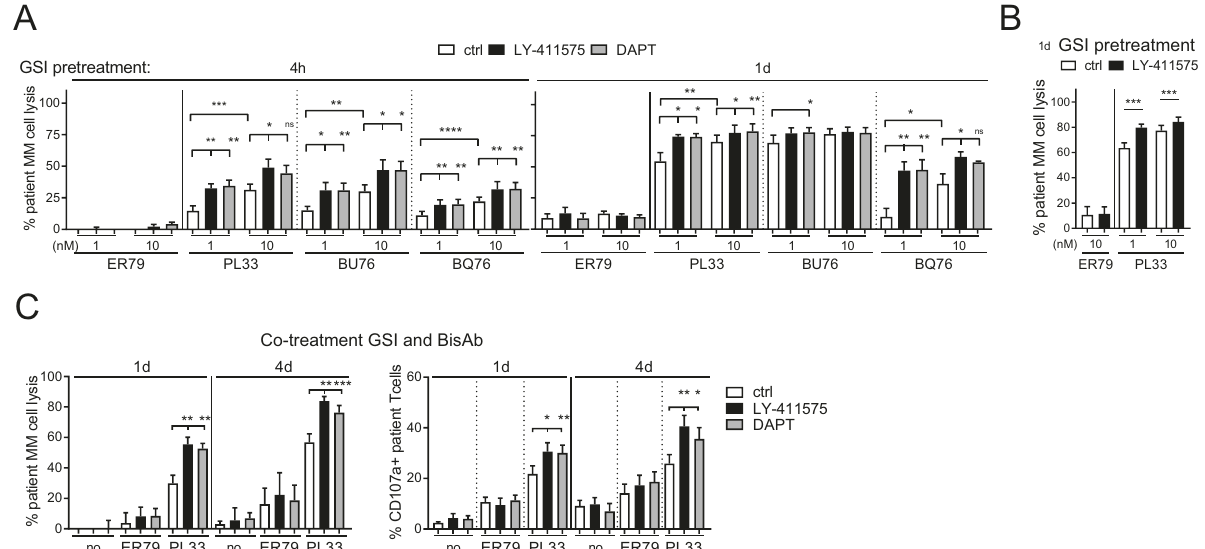
Fig. 4 Pretreatment or co-treatment with GSIs further augmented autologous patient MM cell lysis induced by BCMAxCD3 BisAbs. BMMCs of MM patients ( A , n = 6; B , n = 5; C , n = 8) were pretreated ( A , 4 h and 1 day; B , 1 day) or co-treated ( C ) with GSIs (2 nM LY-411575 or 1 µM DAPT). Indicated BisAbs (1, 10 nM in A , B ; 1 nM in C ) were added with PBMCs from the paired individuals for 1 day ( A , C ) or 4 days ( C ). Quantitative FC analysis was used to determine % patient MM cell (CD138 + ) depletion ( A , B ; C , left panel) and CD107a degranulation in autologous CD3 + patient T cells ( C , right panel). Experiments were done in triplicate for each condition using multiple patient samples. Data are presented as means ± SDs (error bars). * P < 0.05; ** P < 0.01; *** P < 0.001; **** P < 0.0001; ns, not signi fi